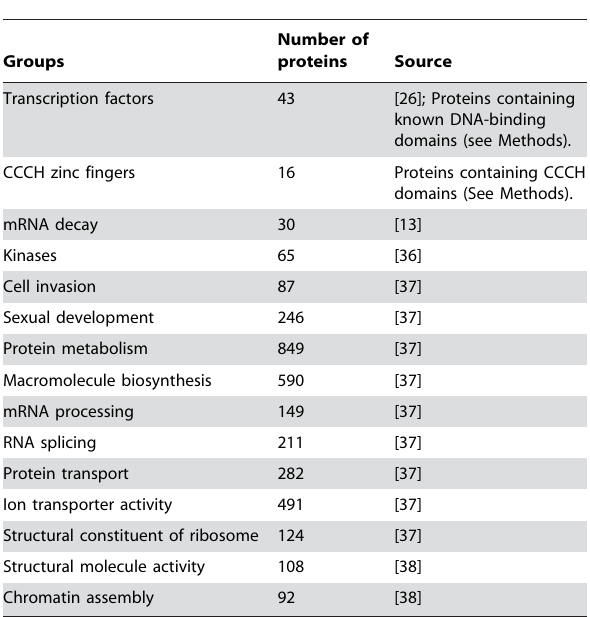
Table 2. Protein groups analyzed, their sizes and sources.